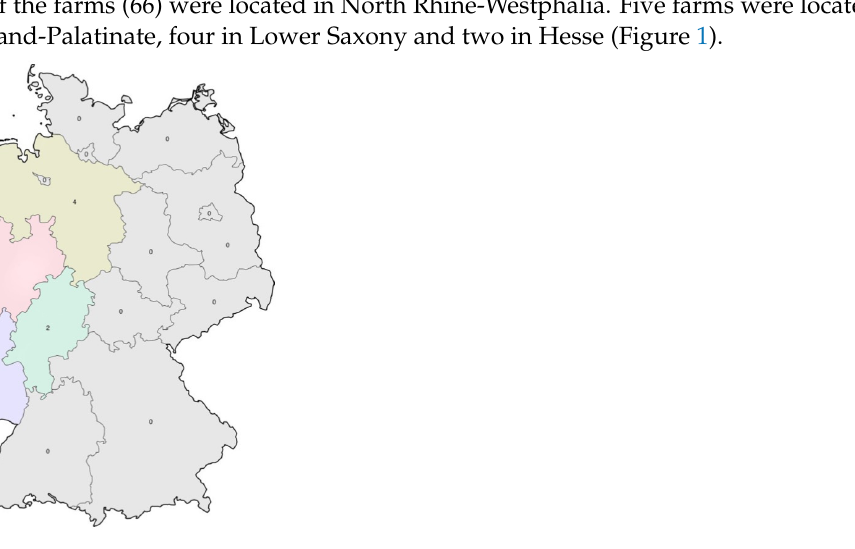
Figure 1. Geographical location in Germany of the surveyed farms. Numbers: number of farms.